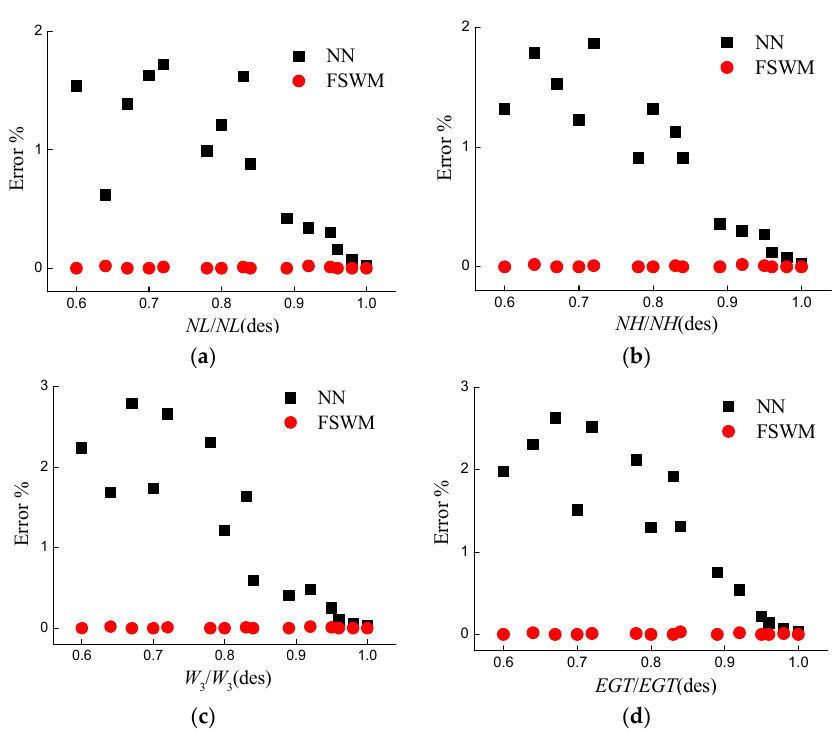
Figure 7. The steady error comparisons of identified engine model between the NN and FSWM: ( a ) NL ; ( b ) NH ; ( c ) W 3 ; ( d ) EGT .